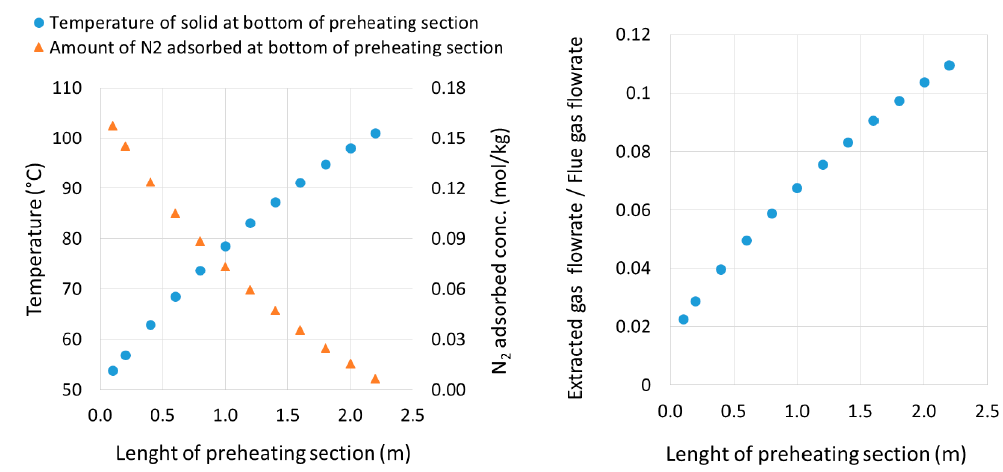
Figure 6. System configuration D: adsorbent temperature and N 2 adsorbed concentration at the outlet of preheating section ( left ) and amount of extracted gas ( right ) for different lengths of preheating section.